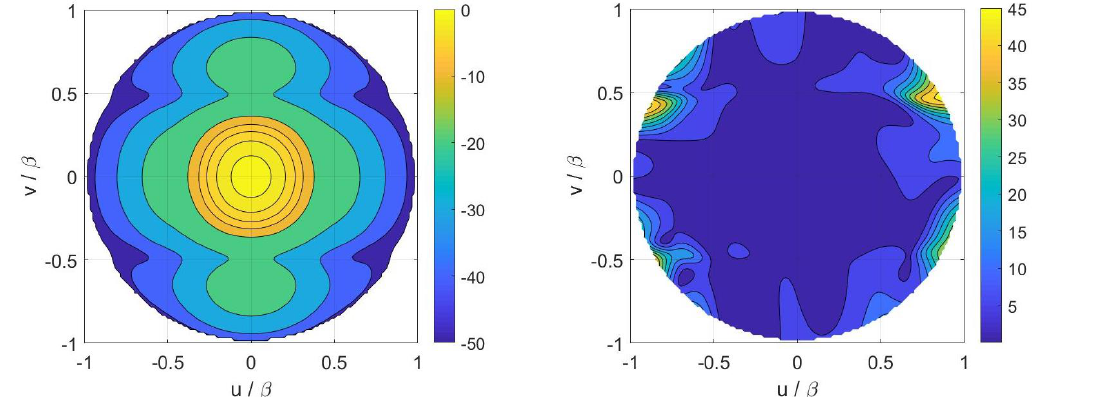
Figure 5. Case A—( Left ) contour plot of the reference FFP. ( Right ) percentage error of the FFP retrieved in the Shannon number case.